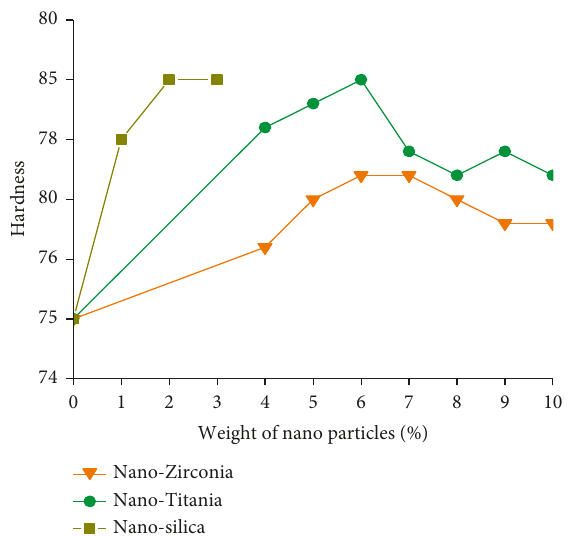
Figure 7: Hardness of nanofilled C-Ph laminate with nanofiller loading.